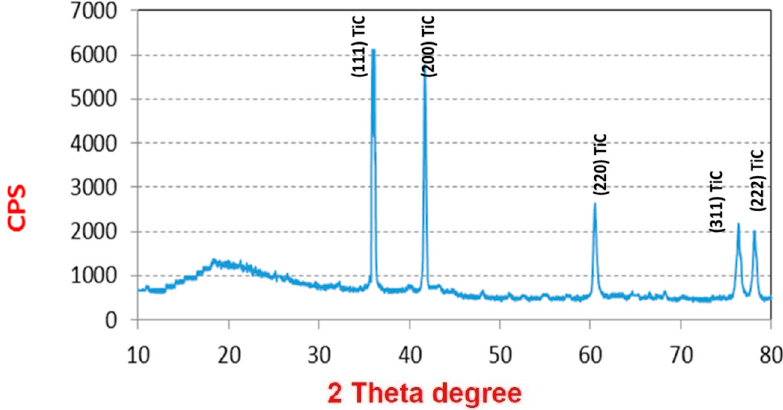
Figure 7. XRD patterns of the TiC calcined fiber at 1000 ˝ C under argon atmosphere.